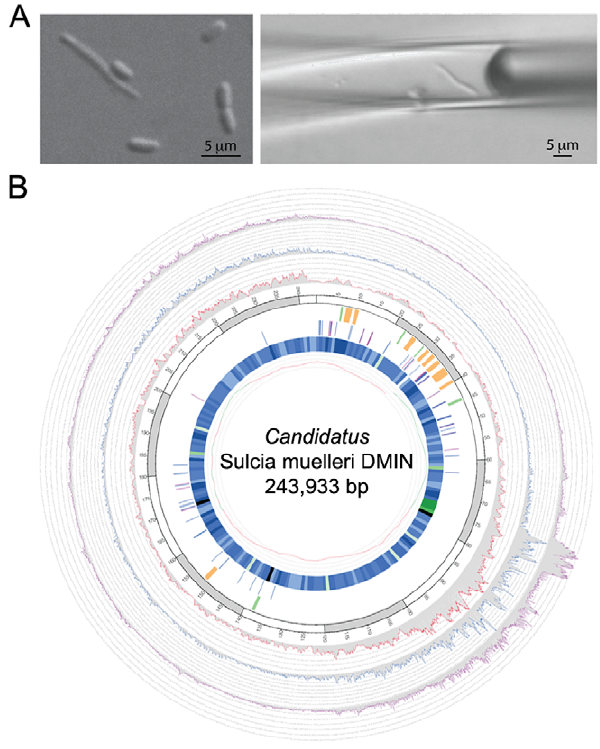
Figure 1. Sulcia cell isolation and sequence coverage, closure and polishing locations along the Sulcia DMIN single cell genome. (A) Micromanipulation of the single Sulcia cell from the sharpshooter bacteriome metasample. (B) Sequence coverage including closure and polishing locations along the finished, circular Sulcia DMIN genome with circles corresponding to following features, starting with outermost circle: (1) Illumina sequence coverage ranging from 0–3276 (mean 303 + 2 386), (2) pyrosequence sequence coverage ranging from 0–231 (mean 42 + 2 39), (3) Sanger sequence coverage ranging from 0– 30 (mean 10 + 2 7), (4) locations of captured (green) and uncaptured gaps (orange), (5) polishing locations corrected using Illumina (blue) and Sanger (purple) seqeunce, (6) GC content heat map (dark blue to light green=low to high values) and (7) GC skew.